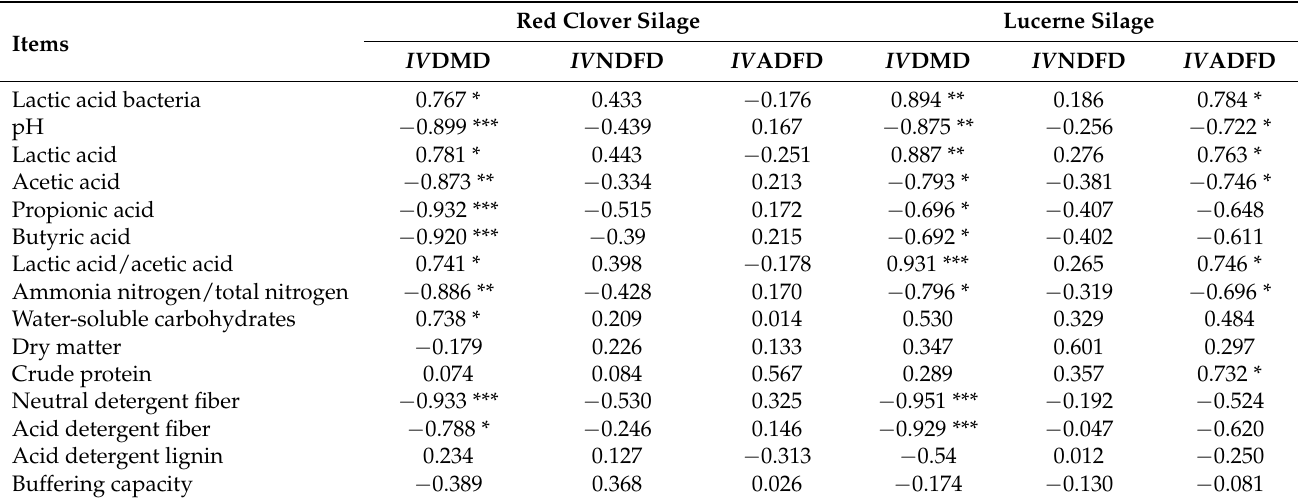
Table 6. Pearson correlation of in vitro digestibility with lactic acid bacteria, fermentation quality, and nutrient composition of red clover silage and lucerne silage (n =